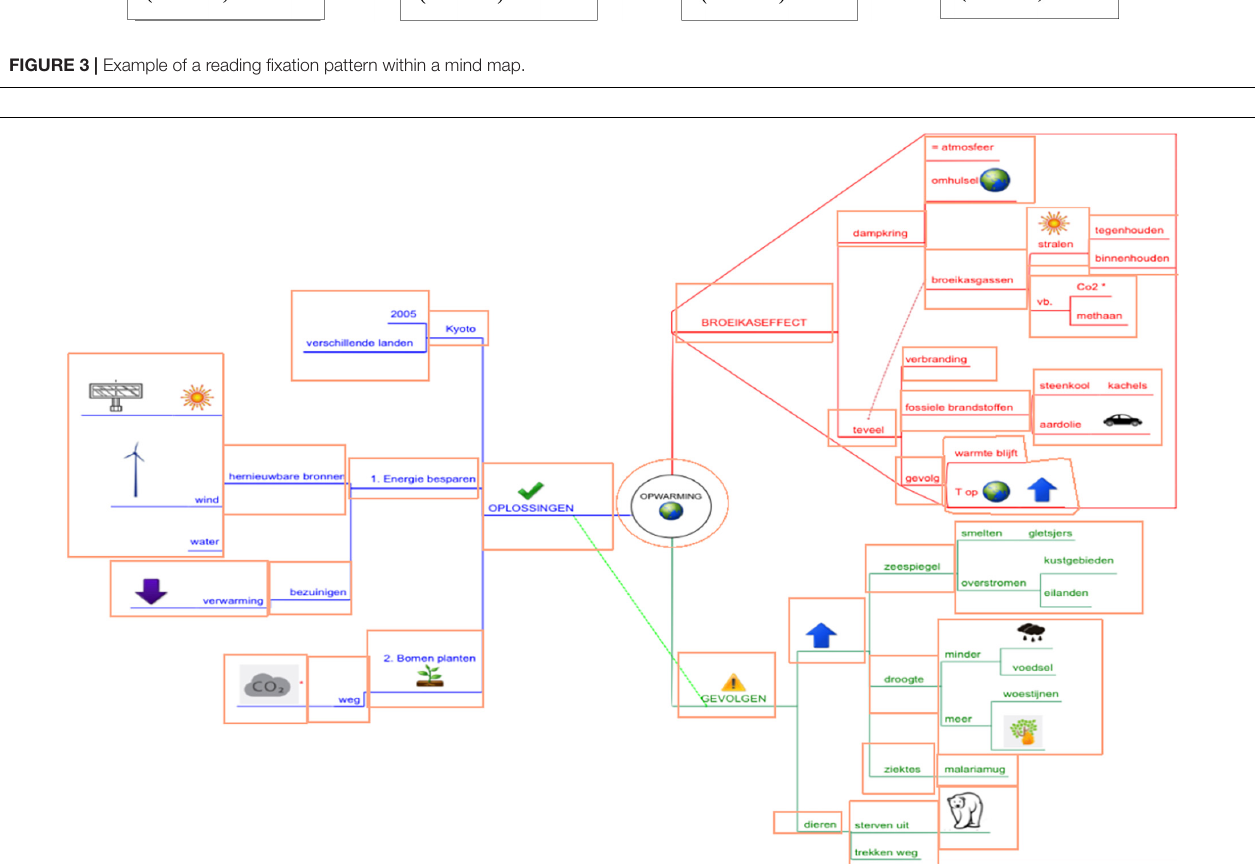
FIGURE 4 | Original mind map (in Dutch) on global warming. In the result section, the mind map is translated into English. The boxes represent the Interest Areas (IA) and were not visible for the participants (see